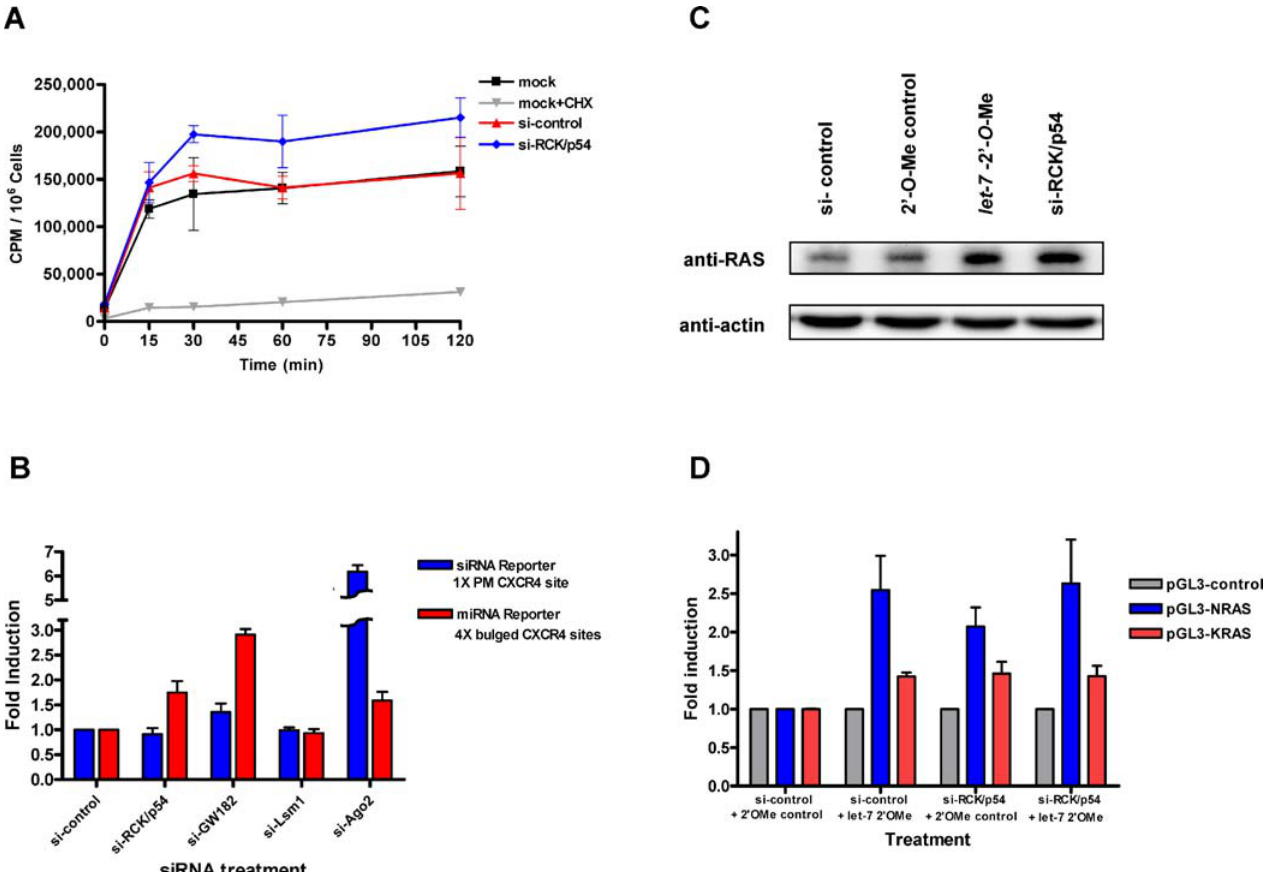
Figure 7. RCK/p54 Represses General and miRNA-Mediated Translation (A) Release of general translational repression by silencing RCK/p54. Incorporation of [ 35 S]methionine into HeLa cells was used to measure general translational activity. Cells were transfected with 50 nM siRNAs targeting mismatched CDK9 (control) or RCK/p54. Mock control cells were treated